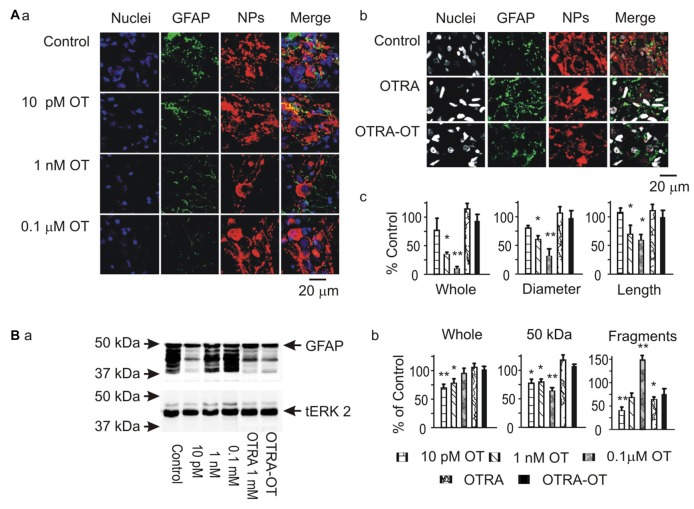
Effects of oxytocin (OT) on glial fibrillary acidic protein (GFAP) plasticity in the supraoptic nucleus (SON) in brain slices from male rats. (A) Effects of OT (10 pM, 1 nM and 0.1 μM for 30 min) and OT receptor antagonist (OTRA, 1 μM for 30 min) on GFAP expression in confocal images. (Aa,Ab) Staining of nuclei, GFAP, neurophysins (NPs) and their merges (left to right). (Ac) Summary graphs showing the intensity of GFAP filaments relative to the control in whole panel, diameters and lengths of the filaments. Note that: *P < 0.05 and **P < 0.01 compared to the control (n = 6) in ANOVA with Holm-Sidak comparisons. (B) GFAP expression in Western blots. (Ba) Bands (left to right) show GFAP proteins (top) for control, 10 pM OT, 1 nM OT, 0.1 μM OT, 1 μM OTRA and 0.1 nM OT after OTRA for 30 min, respectively. Bands at the bottom are total extracellular signal regulated protein kinase 2 (tERK 2), serving as loading controls for corresponding treatments (n = 6, compared in ANOVA). (Bb) Summary graphs showing GFAP relative to control in whole bands, bands at 50 kDa (full size), and their smaller fragments, respectively.